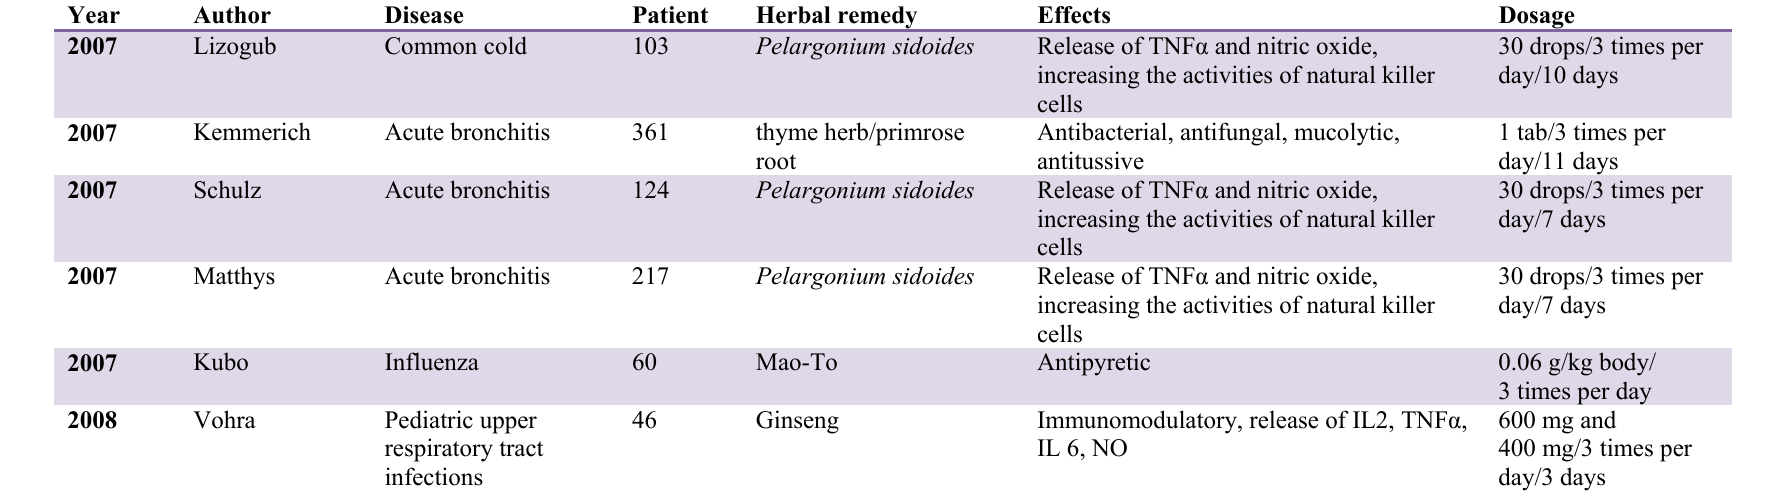
Table 3. Herbal remedies in the treatment of upper and lower respiratory tract